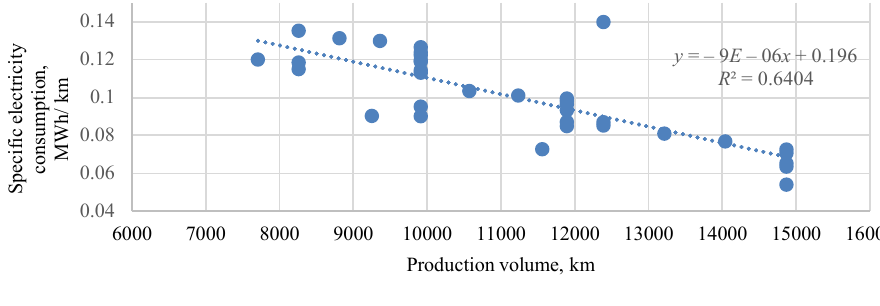
Fig. 5. Linear regression analysis for specific electricity consumption